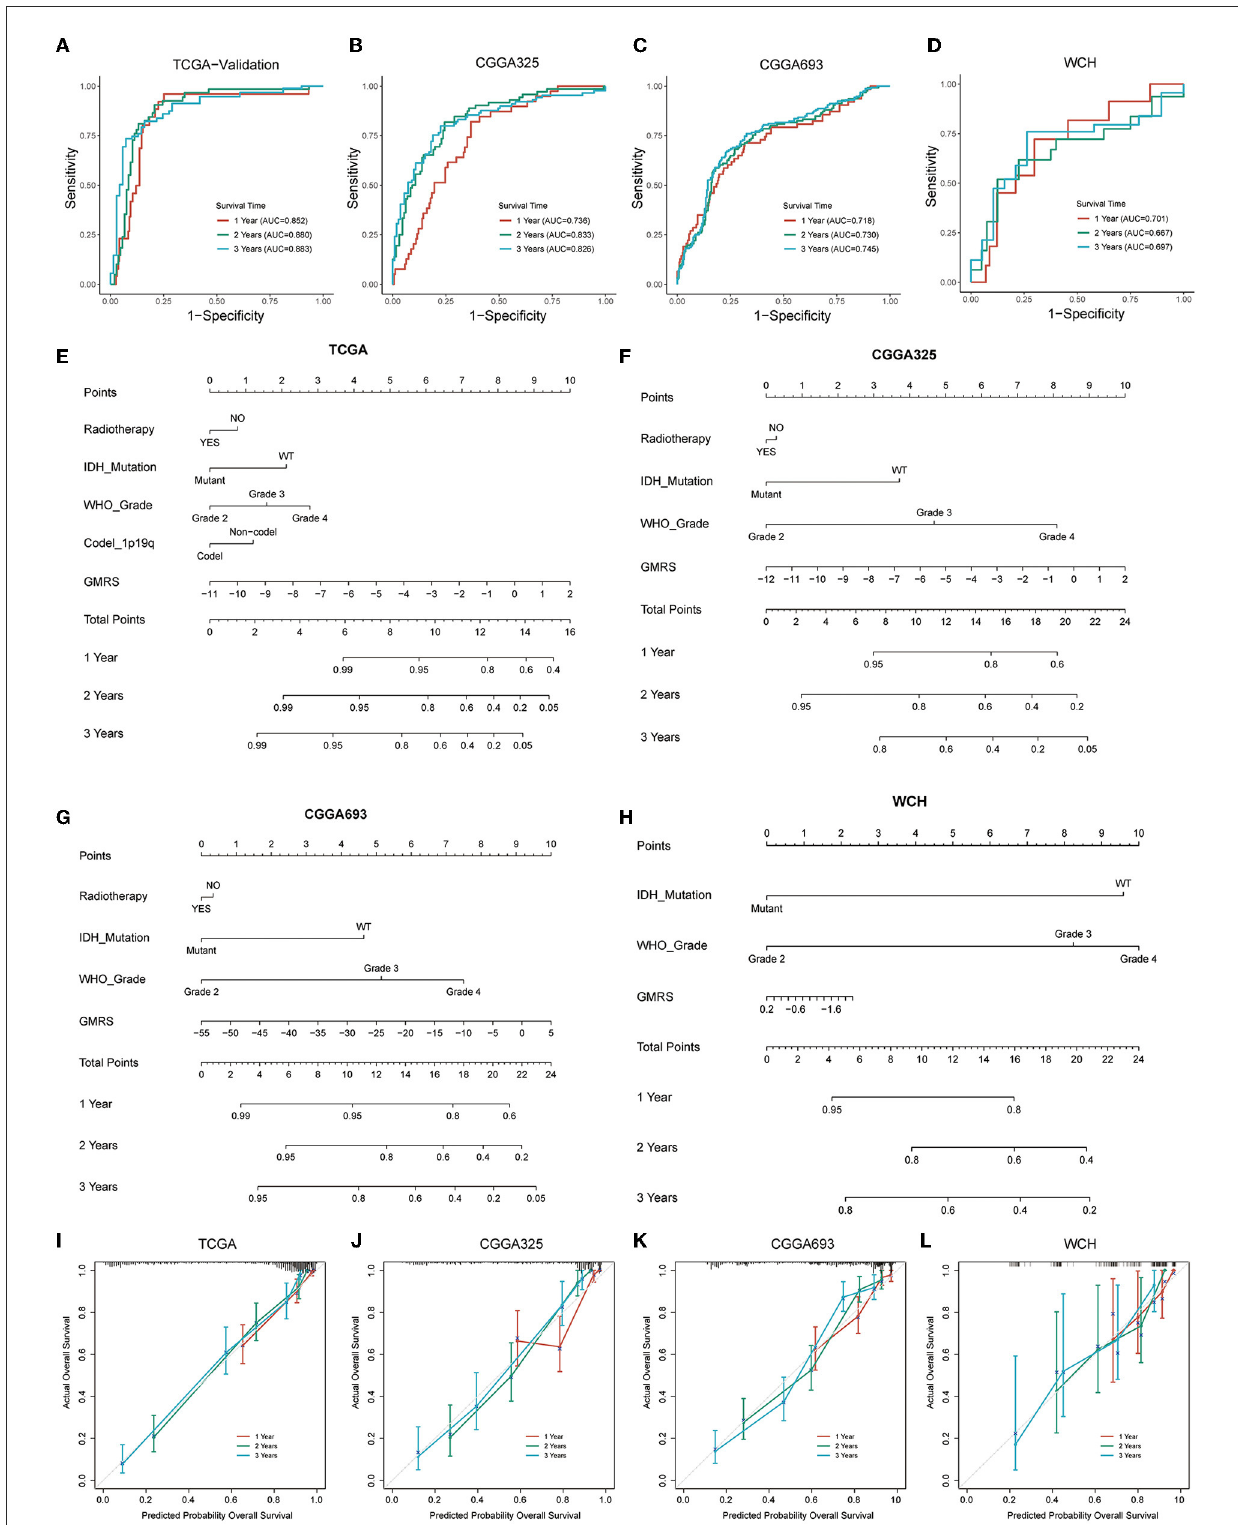
FIGURE7 Prognostic predictive performance of GMRS and nomogram construction. (A–D) ROC curves for predicting 1-, 2-, and 3-year overall survival in the TCGA, CGGA325, CGGA693, and WCH cohort; (E–H) nomogram construction based on independent prognostic clinical variables; and (I–L) calibration curve for assessing the performance of each nomogram. GMRS, glutamine metabolism risk score; ROC, receiver operator characteristic; TCGA, The Cancer Genome Atlas; CGGA, Chinese Glioma Genome Atlas; WCH, West China